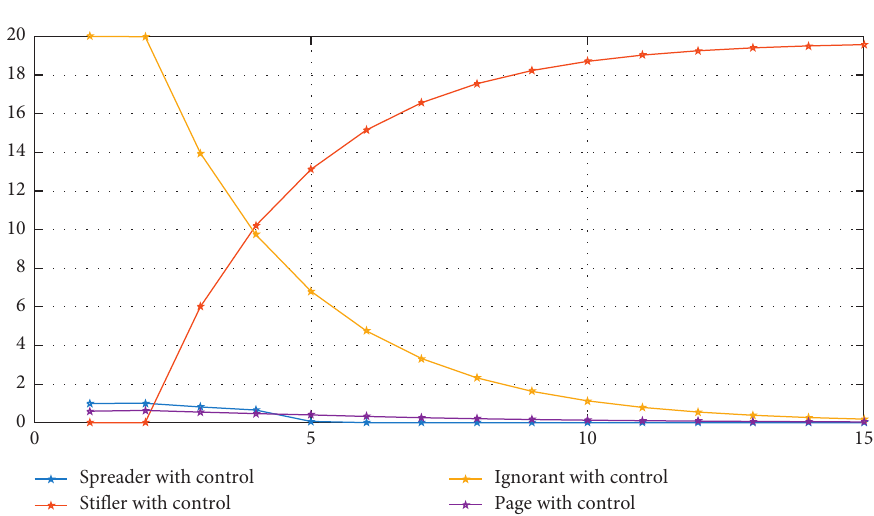
Figure 3: Dynamics with controls u , v , and w .